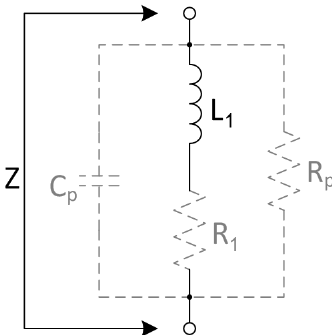
Figure 2. Lumped element model of a simple coil impedance Z , consisting of the main inductance L 1 , the equivalent series resistance R 1 , the parallel resistance R p and the parasitic parallel capacitance C p